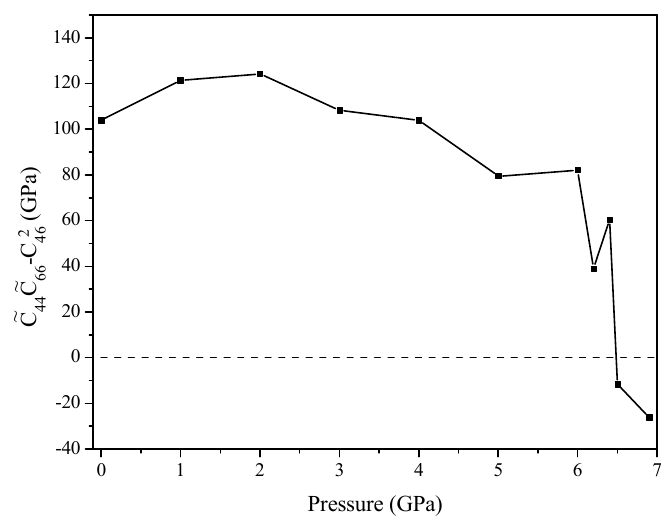
0   C Figure 4. Calculated  of C 2/ m -Ca 2 C under different pressures. r r C 44 C 66 ´ C 2 Figure 4. Calculated of C 2/ m -Ca 2 C under different pressures.   46 Figure 4. Calculated  of C 2/ m -Ca 2 C under different pressures.